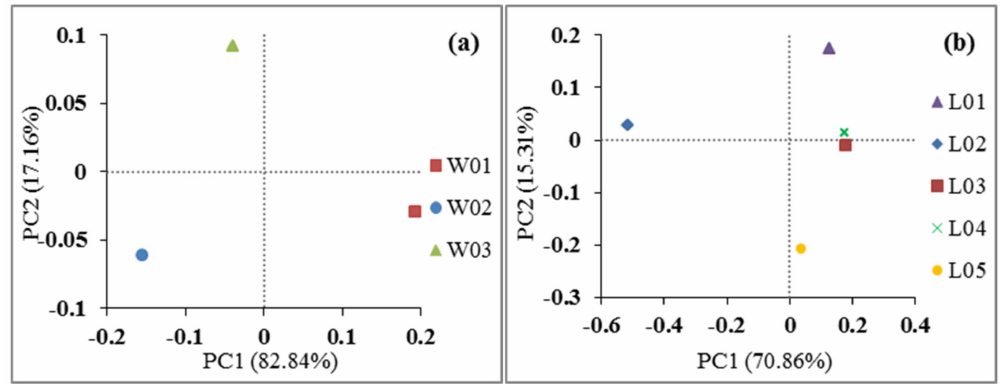
Figure 8. Principal component analysis (PCoA) of soil bacterial community diversity. ( a ) represents the samples from di ff erent depths, and ( b ) represents the samples from di ff erent vegetation